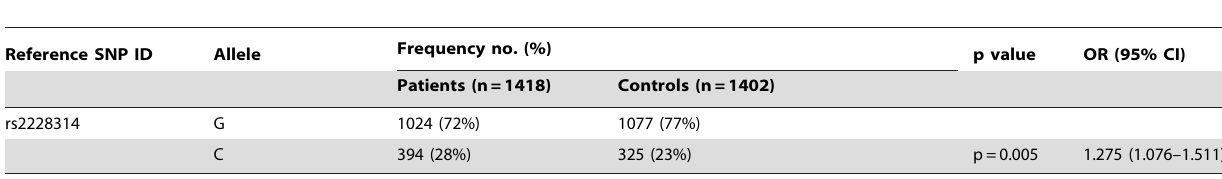
Table 2. Alleles of 1784G . C (rs2228314) polymorphism in SREBP-2